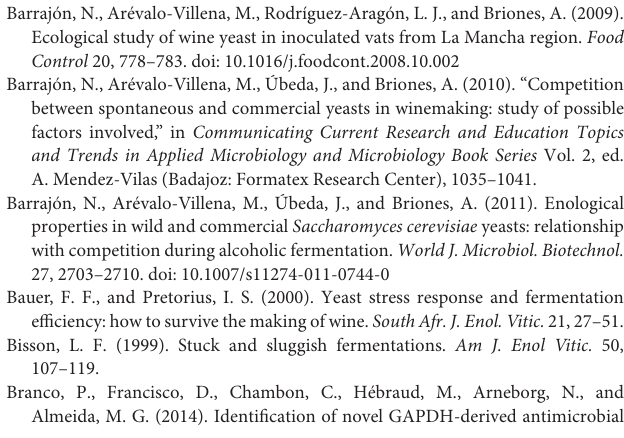
Together with proteinaceous antimicrobial compounds, medium fatty acids, produced during alcoholic fermentation above a given threshold, could exhibit inhibitory actions toward S. cerevisiae and/or other species (Viegas et al., 1989). Cell-to-cell contact is the other mechanism that could influence the interaction among yeast strains. Nissen et al. (2003) demonstrated this phenomenon carrying out single- and mixed-culture fermentations using both L. thermotolerans and T. delbrueckii with S. cerevisiae